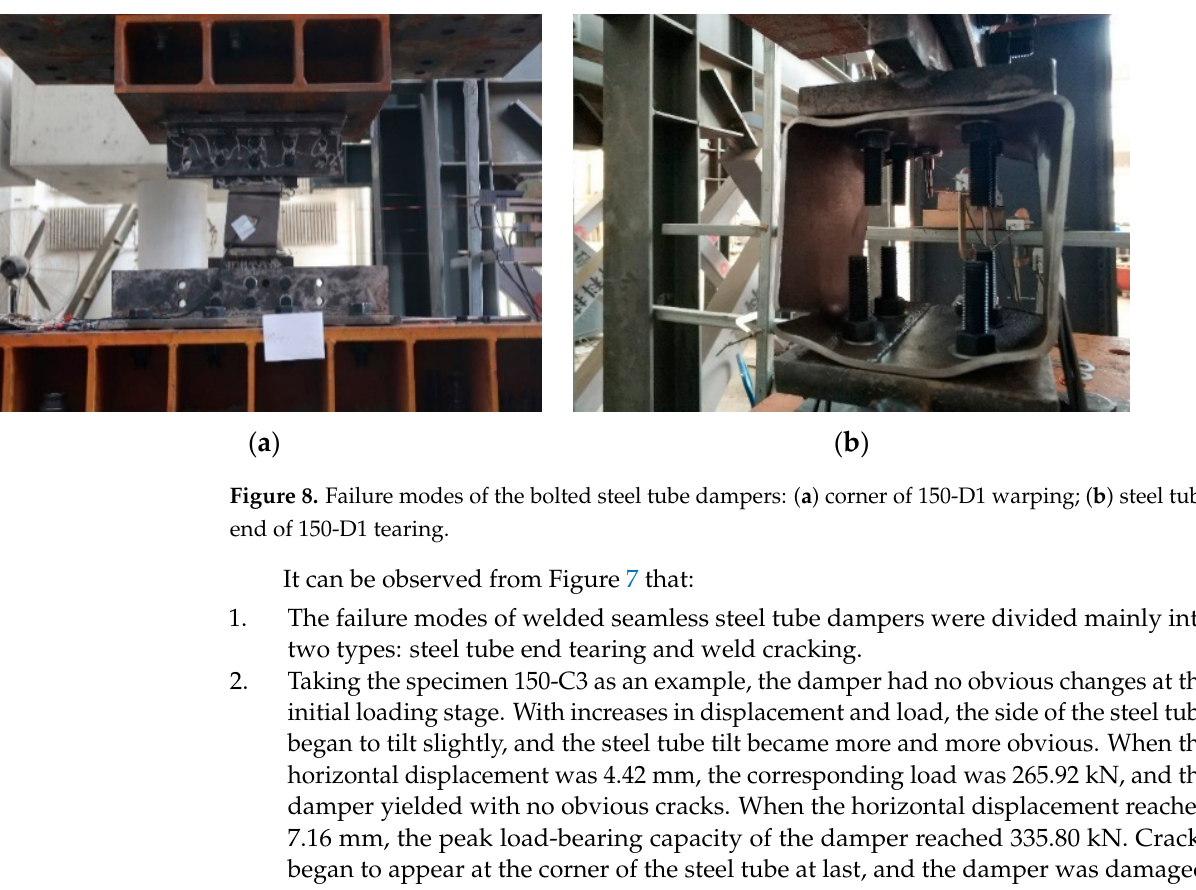
Figure 8. Failure modes of the bolted steel tube dampers: ( a ) corner of 150 ‐ D1 warping; ( b ) steel tube end of 150 ‐ D1 tearing.